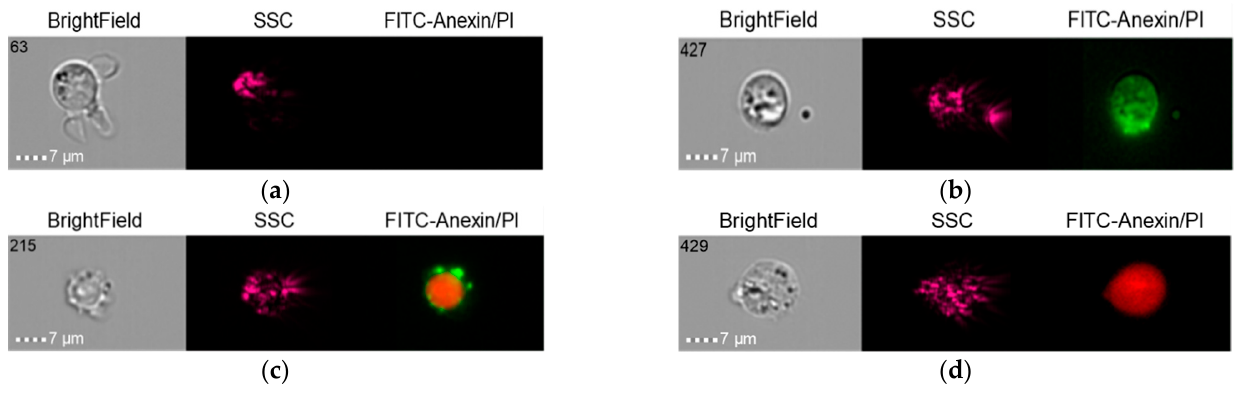
Figure 7. Live cells ( a ), early apoptosis ( b ), late apoptosis ( c ), necrosis ( d ) after co-culture of Nobel Replace NSMP with THP-1 cell line (Nobel Replace NSMP + LPS + THP-1).